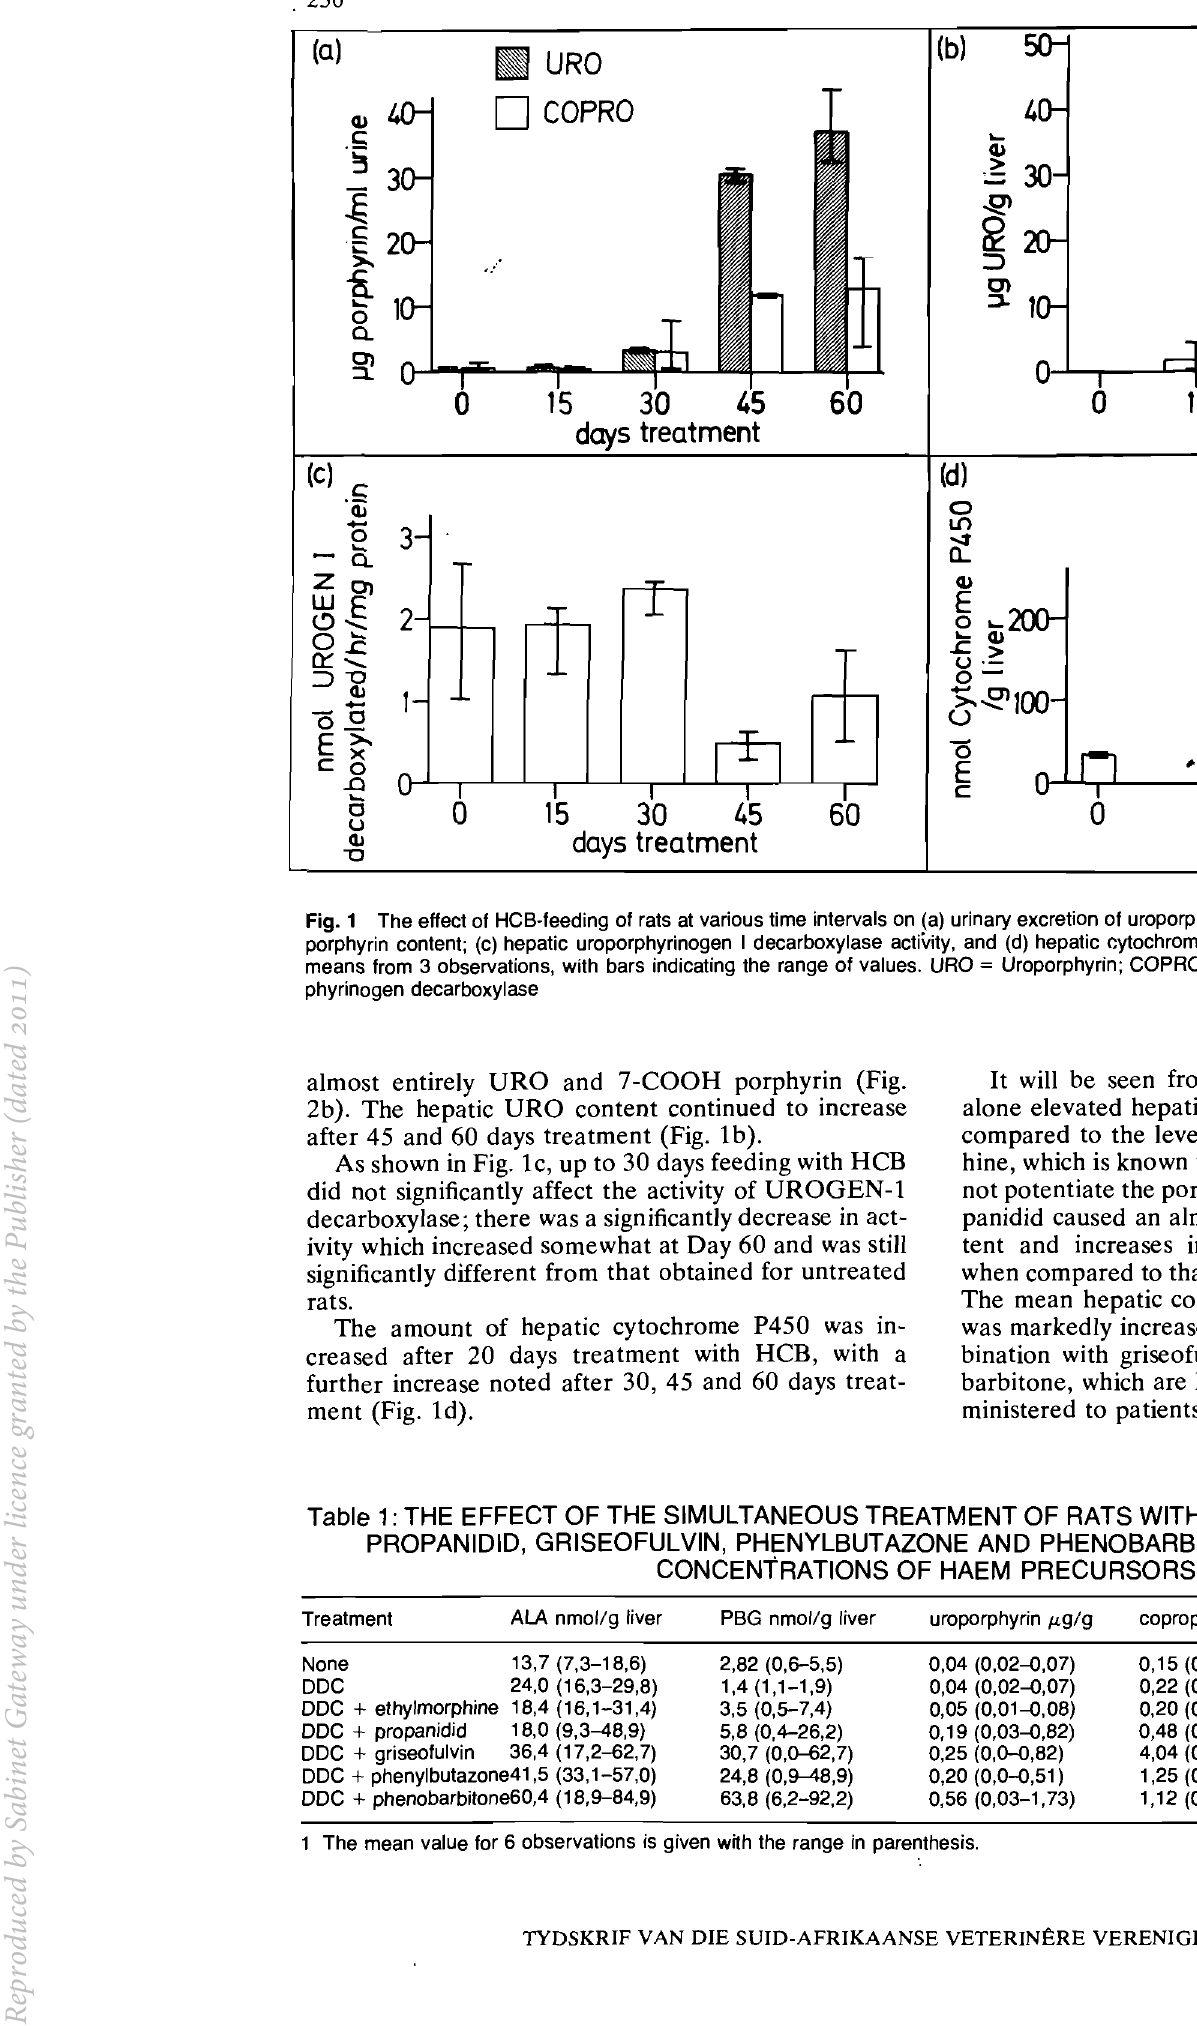
Table 1: THE EFFECT OF THE SIMULTANEOUS TREATMENT OF RATS WITH DDC AND ETHYLMORPHINE, PROPANIDID, GRISEOFULVIN, PHENYLBUTAZONE AND PHENOBARBITONE ON THE HEPATIC CONCENTRATIONS OF HAEM